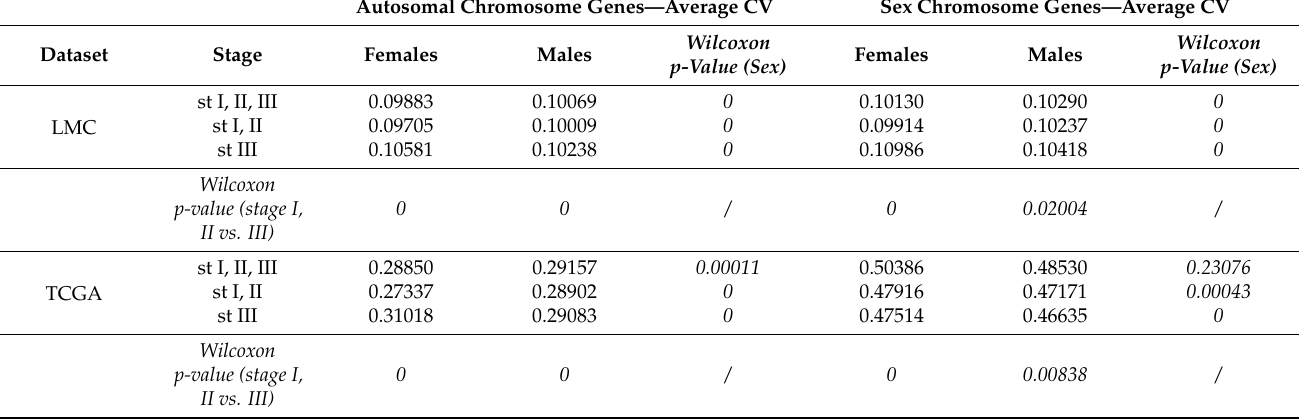
Table 4. Average coefficients of variation on the autosomal and sex chromosome genes of the melanoma (LMC, TCGA, GSE53118) and non-melanoma (Nevi, Normal skin) datasets were calculated for both females and males in the stratified stage groups. A Wilcoxon paired test between females and males was performed on the total number of genes included in every subcategory. The paired Wilcoxon test was also performed between stages I, II and stage III within the same sex on LMC and TCGA datasets. S-E =